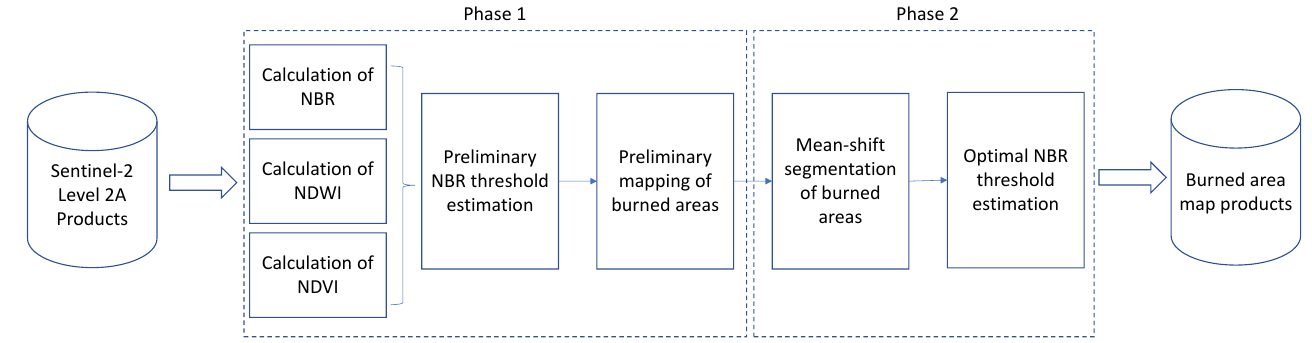
Figure 2. Flowchart diagram of the proposed approach for automatic burned area mapping.